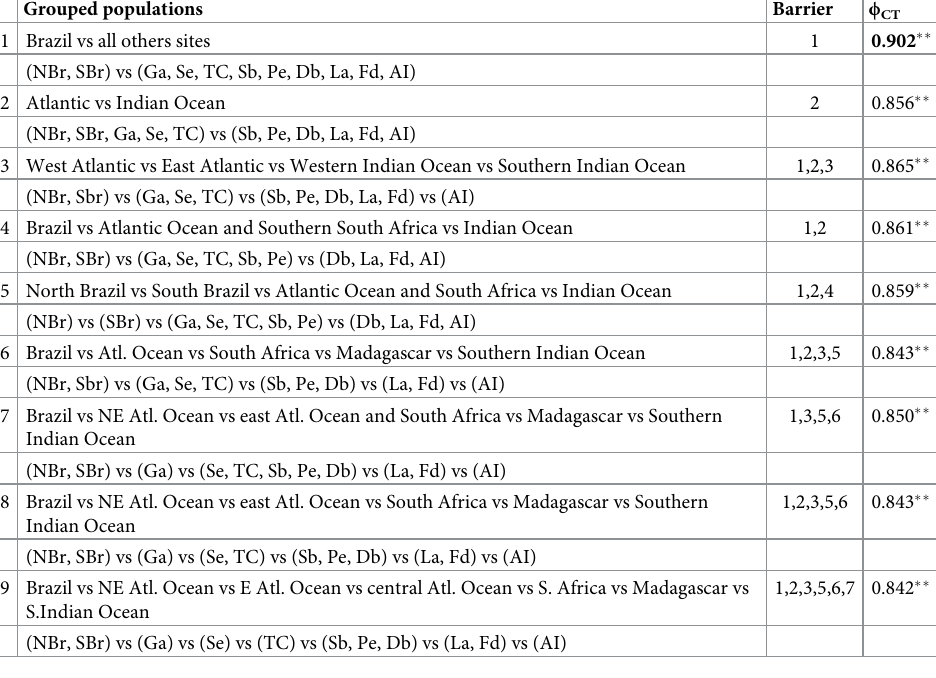
Table 4. Hierarchical AMOVA of Octopus vulgaris populations. Grouped populations